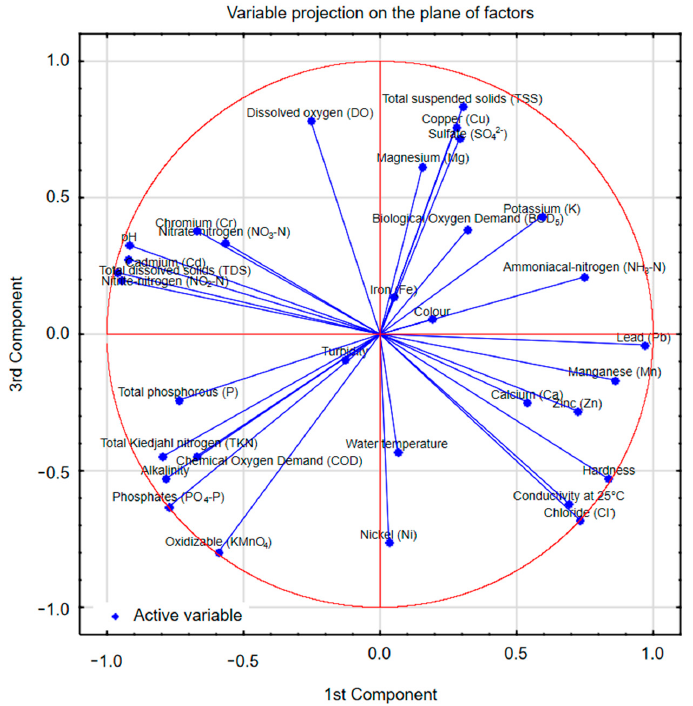
Figure 13. Projection of variables on component 1 and component 3 plane.